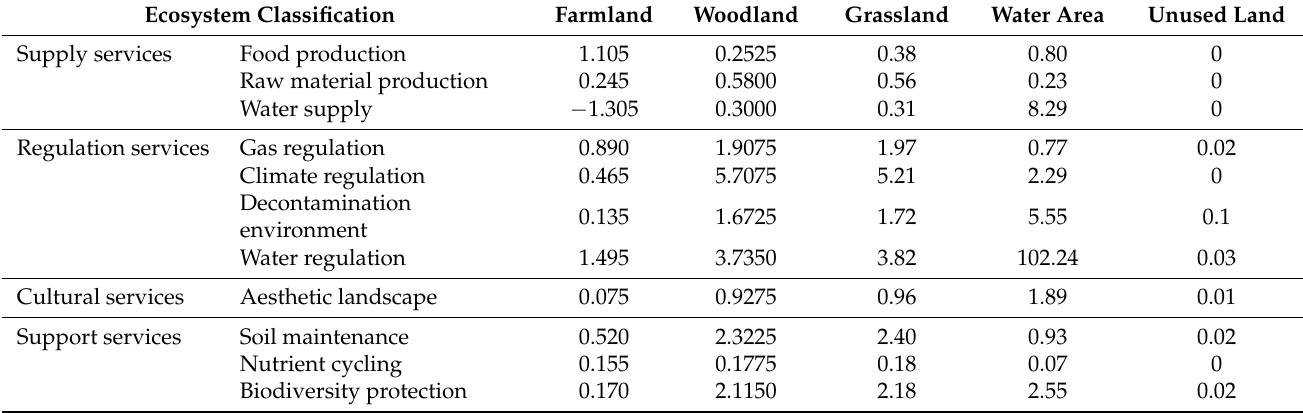
Table 1. Revised ecosystem service equivalent value per unit